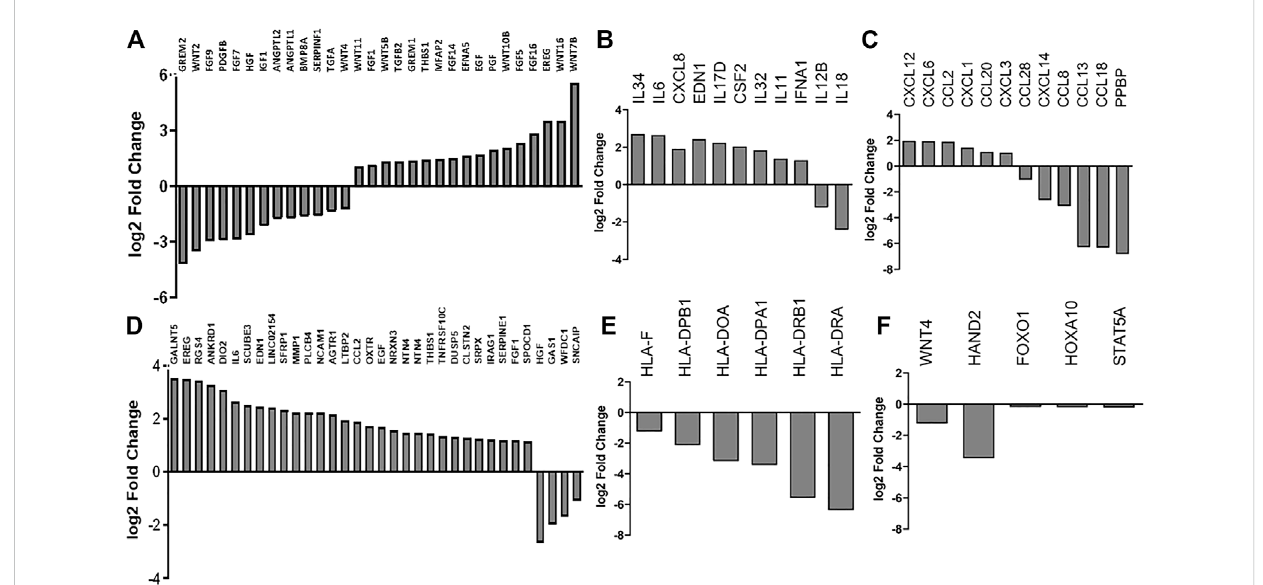
RNA-seqanalysisofnativeandcryostromalcells.Theexpressionofhighlydifferentiallyexpressedgenesenrichedbythefunctionalblocksrelatedto (A) growthfactors, (B) cytokines, (C) chemokines, (D) senescence-associated, (E) antigen-presenting,and (F) fertility-relatedgenes.Dataarerepresented as a fold change of the relative level of gene expression in cryo cells to native ones.